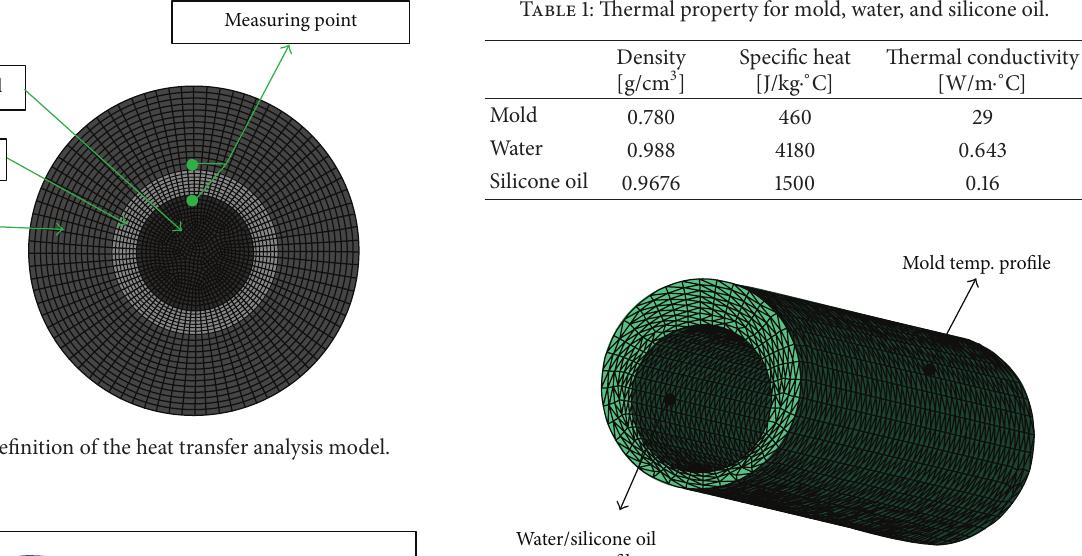
the removal of fluid that remains inside the molding product, after which the final product is ejected.